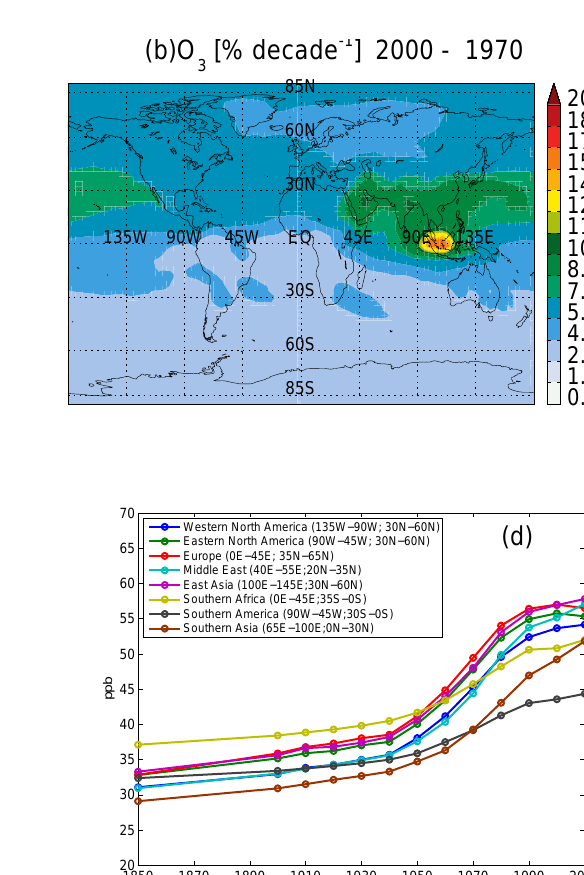
− 1 ) in surface O 3 (a) and